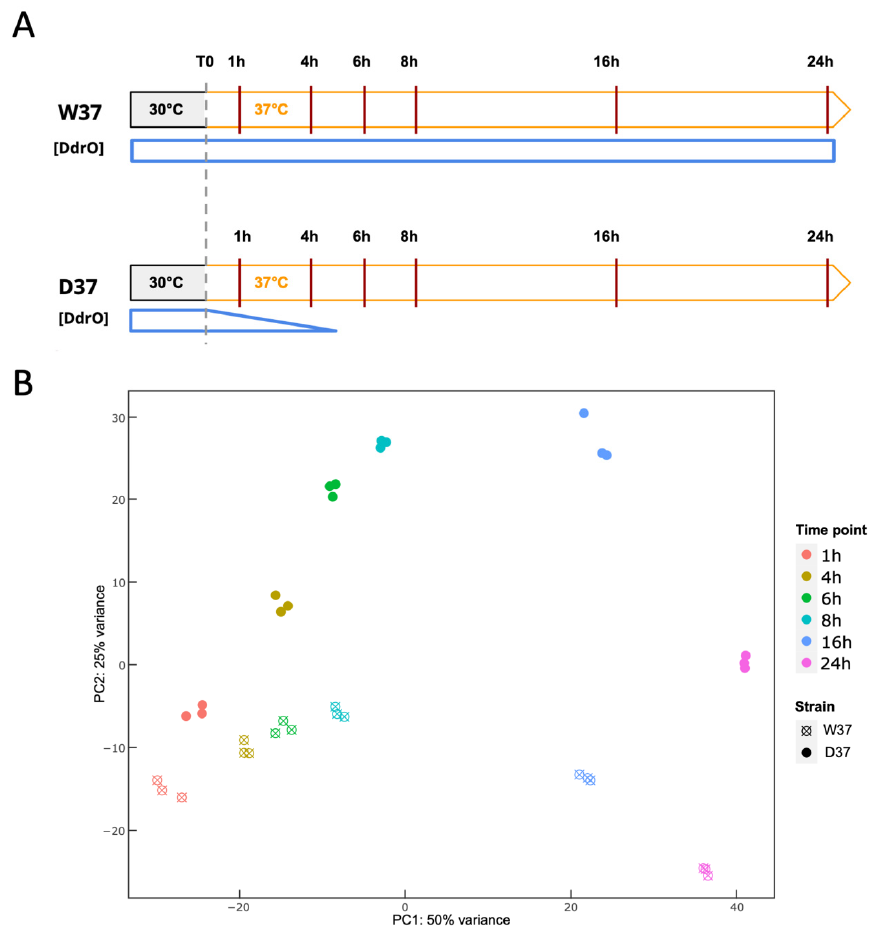
Figure 4. Transcriptomic analysis of DdrO depletion. ( A ). Schematic representation of the transcriptome time course. D37 and W37 cells were first cultivated at 30 °C and exponentially growing cells were rapidly transferred to 37 °C. The six time points examined are indicated by vertical lines. The amount of DdrO during the time course in both strains is indicated by blue plots. ( B ). Principal component analysis of all D37 and W37 samples after temperature shift. Each replicate was plotted as an individual data point. The indicated times are relative to the temperature shift time point (0 h).